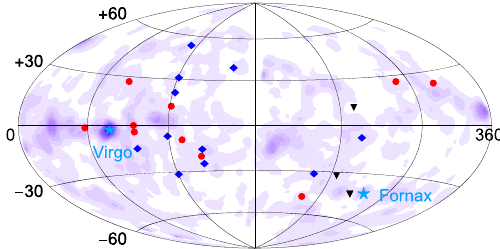
Fig. 3 ObjectswithanomaloushardeningsinVHE(redcircles),HiRes stereo UHE air showers correlated with BL Lac type objects (blue diamonds) and gamma-ray bursts detected in VHE (black triangles) togetherwiththeweightedgalaxydistribution(densityplot)intheceles- tial sphere (supergalactic coordinates)